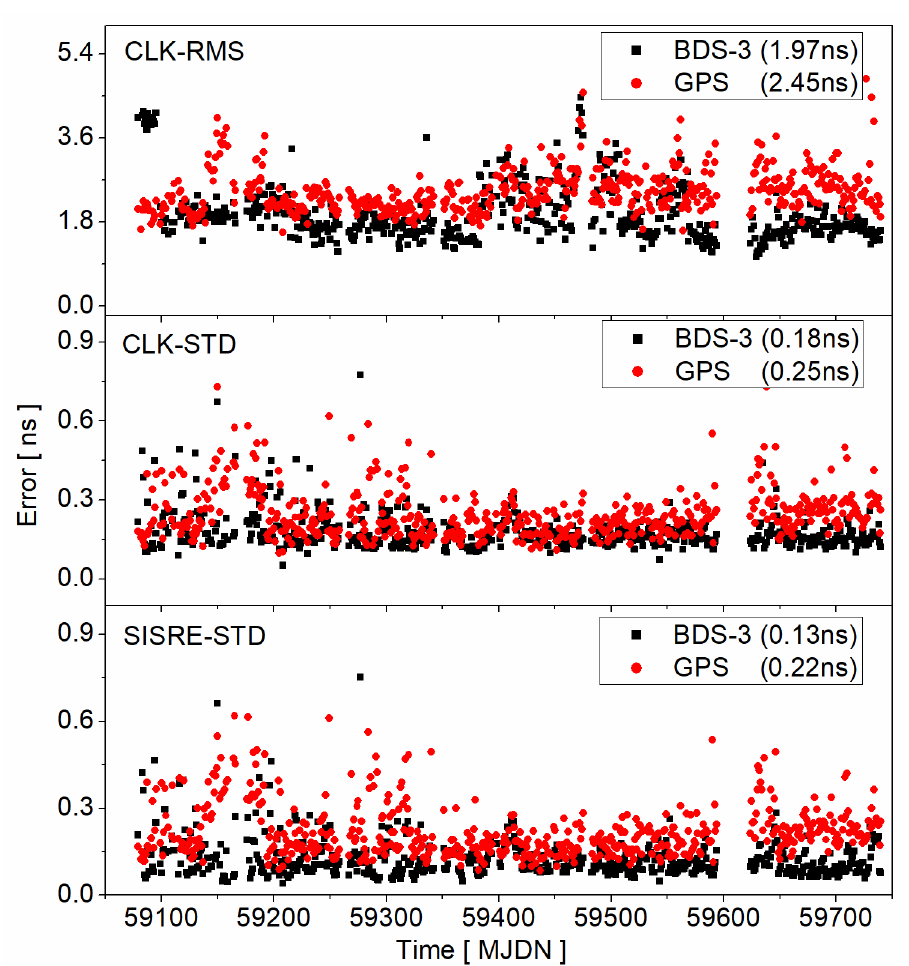
Figure 6. Time series of satellite clock error and SISRE for PPP-B2b products; Black squares and red cycles represent BDS-3 and GPS, respectively; top, middle, and bottom panels are satellite clock RMS, satellite clock STD, and SISRE STD, respectively.